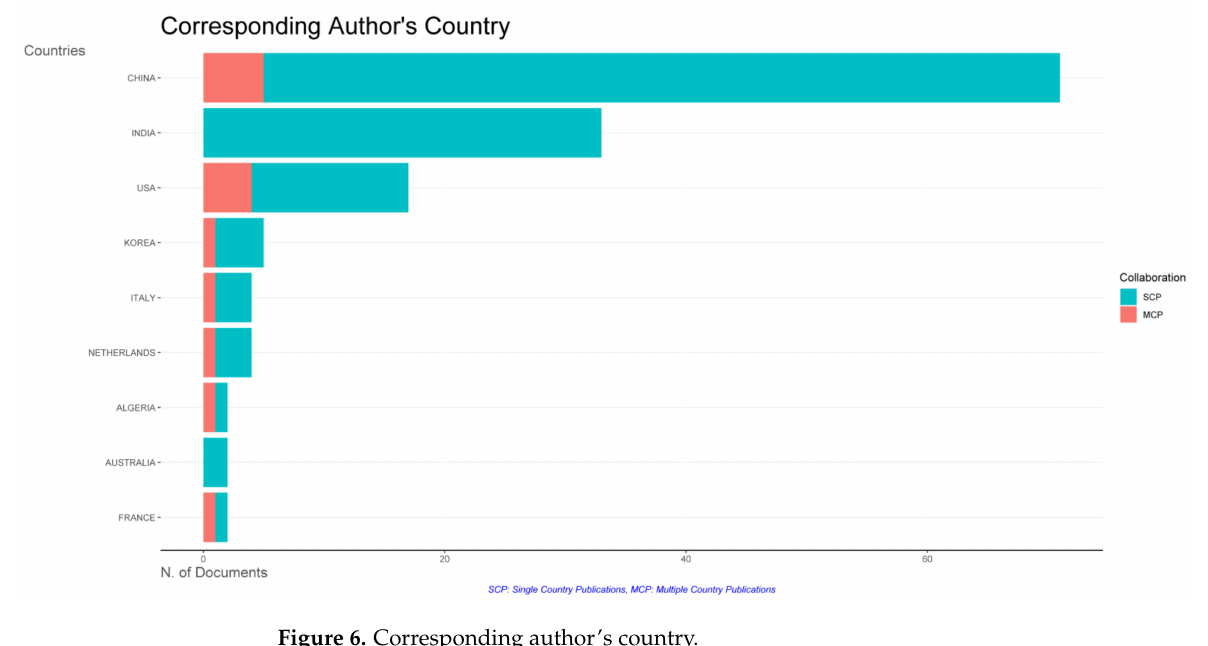
Figure 6. Corresponding author’s country.